Question: Briefly state, in one sentence, what is plotted here.
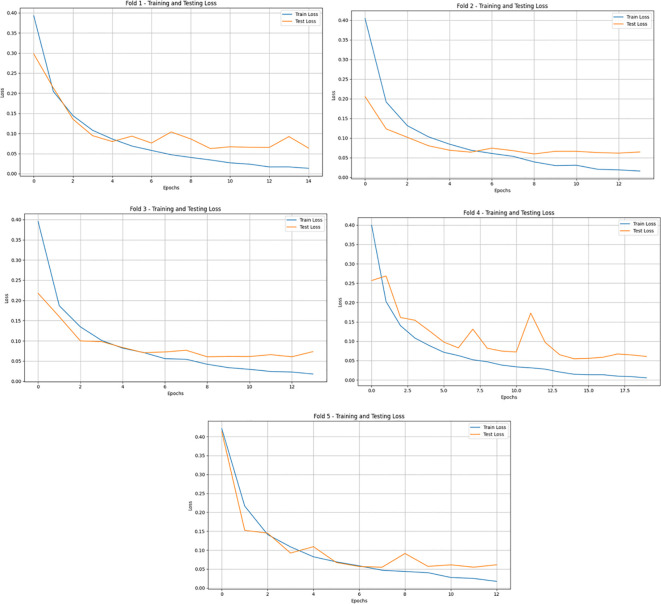
Answer: Loss of performance of TF model.